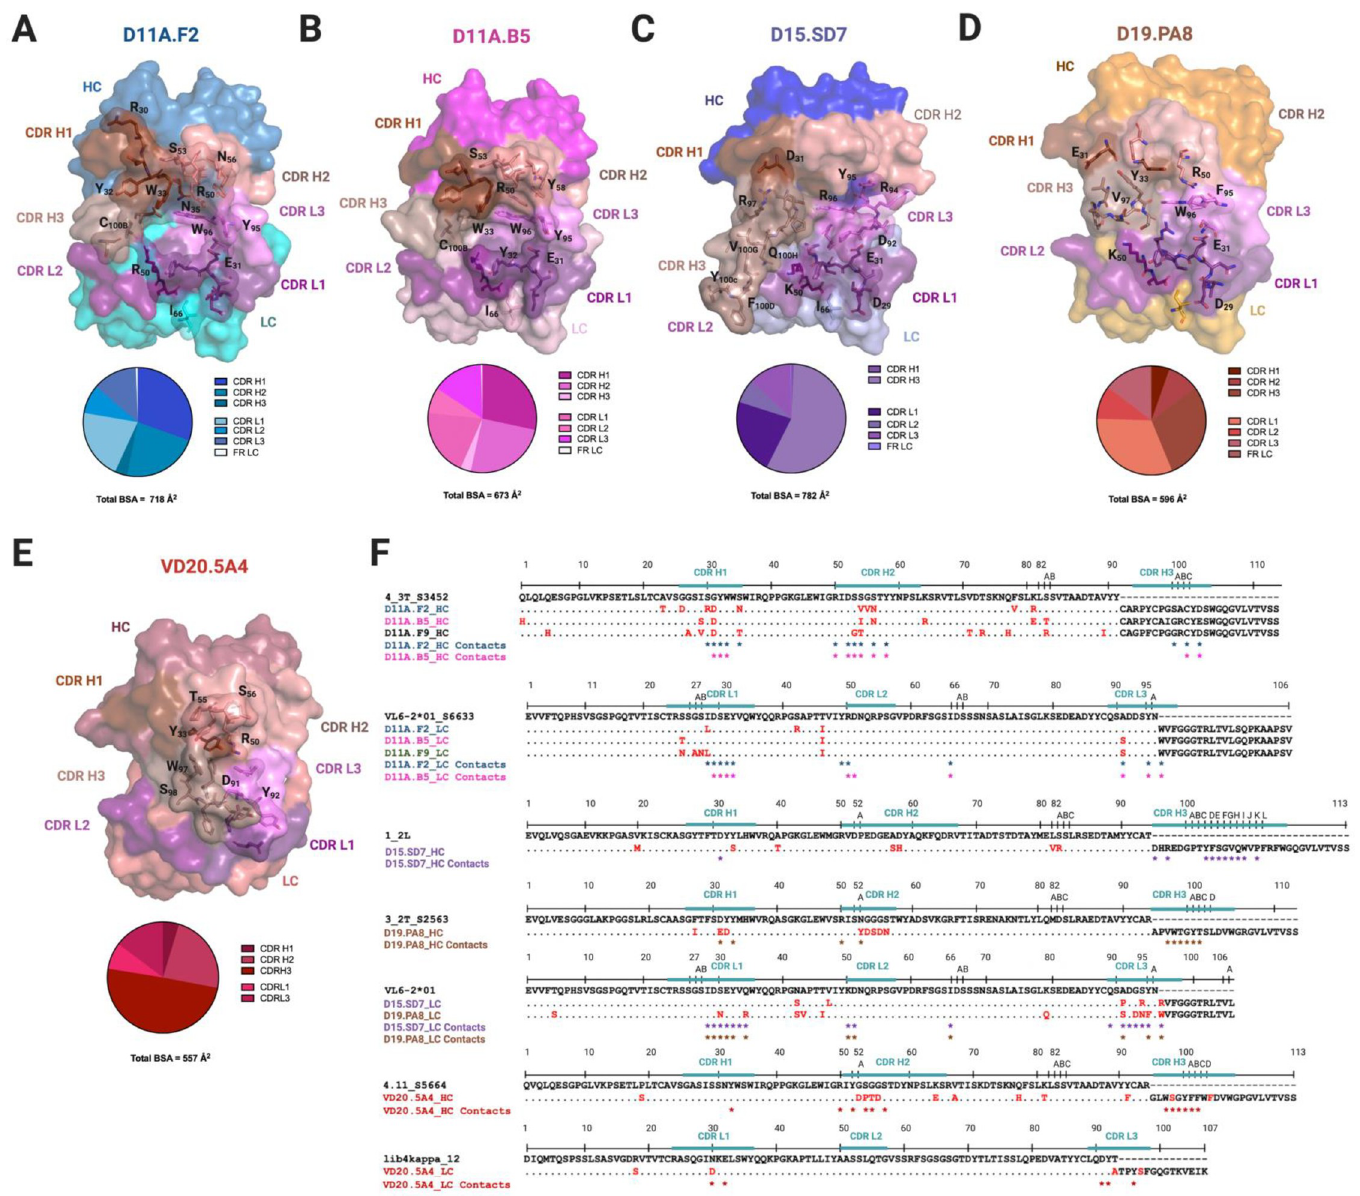
Fig 3. Structural characterization of mAbs elicited from vaccination. Surface representations of (A) D11A.F2, ( B) D11A.B5, ( C) D15.SD7, ( D) D19.PA8, and ( E) VD20.5A4 Fabs. All mAbs are color coded as follows: CDR H1, chocolate; CDR H2, salmon; CDR H3, dark salmon; CDR L1, violet purple; CDR L2, deep purple and CDR L3, violet. The pie chart represents the relative contribution of each CDR loops to the total buried surface area of the paratope for each mAbs. (F) Sequence alignment of the mAbs to their germline genes with CDRs highlighted. Somatic hyper mutations (SHMs) are highlighted in red. Residues interacting with 16055 V2b peptide or 16055 V1V2 are shown as asterisks below the sequence (contact residues within 5 Å